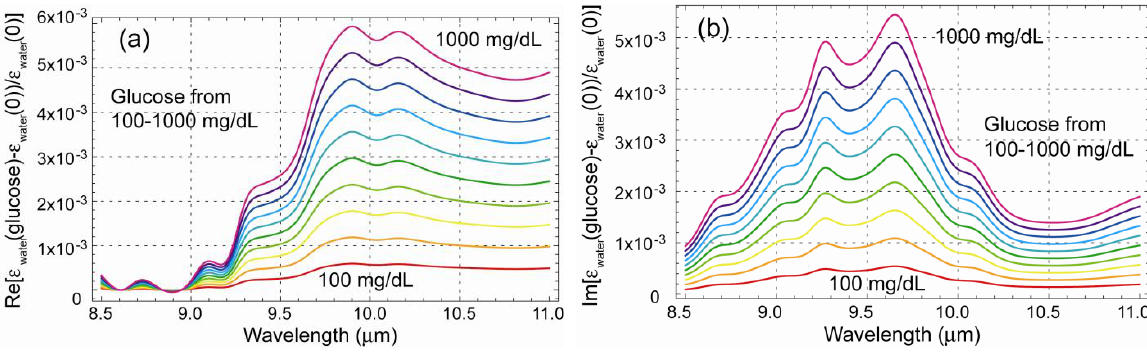
Figure 12. (a) and (b): The Re and Im part of the glucose-induced change of water dielectric constant as a function of glucose concentration, relative to that of pure water.